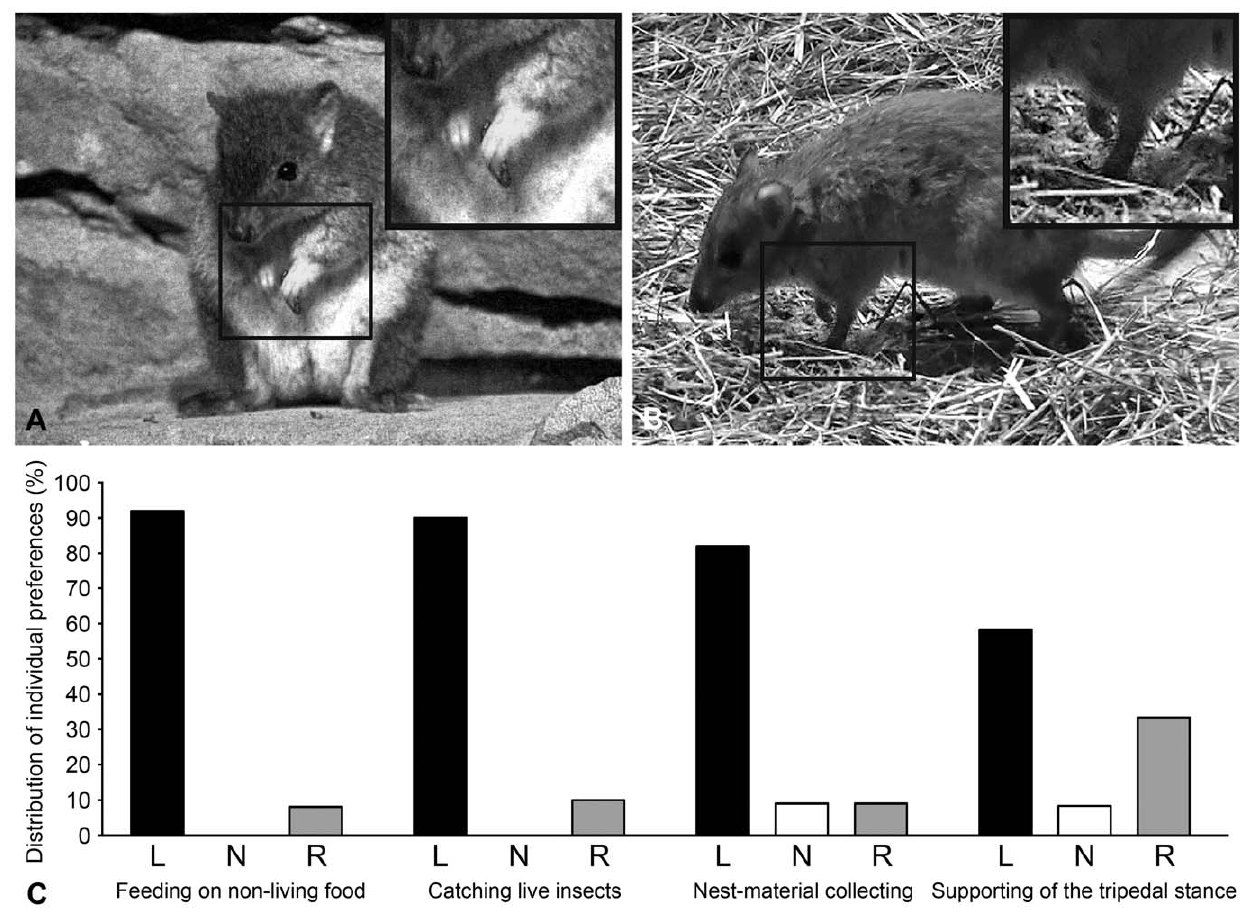
Figure 1. Unimanual forelimb use in brush-tailed bettongs. Two examples of behaviours investigated: ( a ) feeding on non-living food, ( b ) supporting the body in the tripedal stance. Framed body areas are shown enlarged at the corner insertions. ( c ) Percentage distribution of left- forelimb preferent (L), right-forelimb preferent (R) and non-preferent (N) individuals for unimanual feeding on non-living food ( n =12), catching live insects ( n =10), nest-material collecting ( n =11) and supporting of the tripedal stance ( n =12).